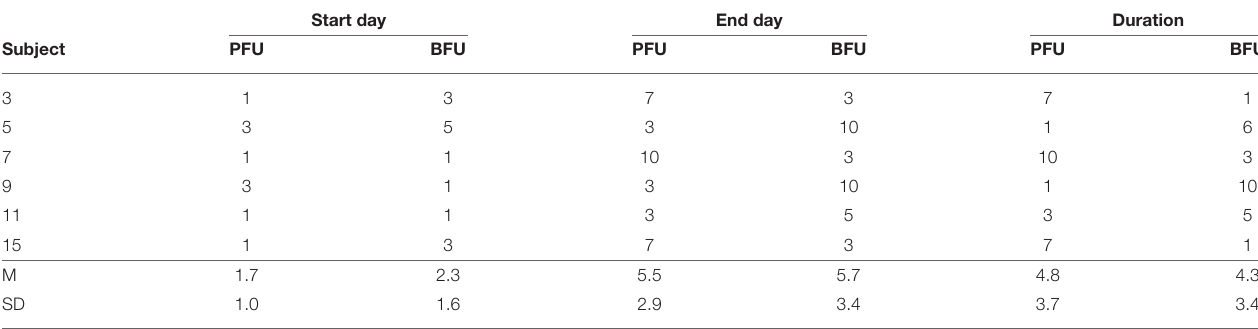
TABLE 5 | Start day, end day, and duration of PFU and BFU occurring in the same subject. Start day End day